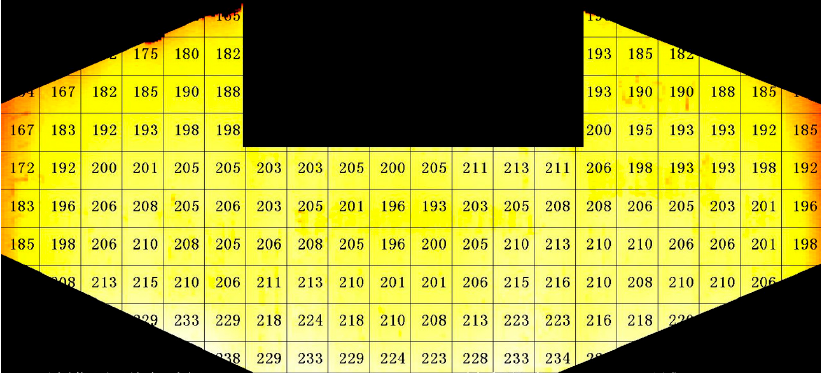
Figure 7. Thermal imaging and axial temperature profile.